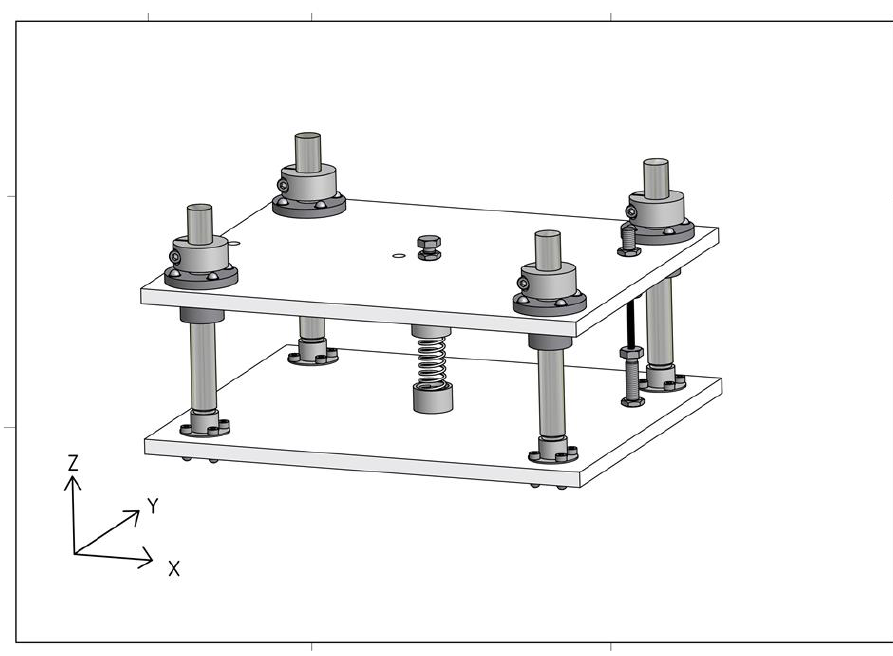
Figure 4. Grinding Simulator CAD illustration. Fraunhofer IPA.